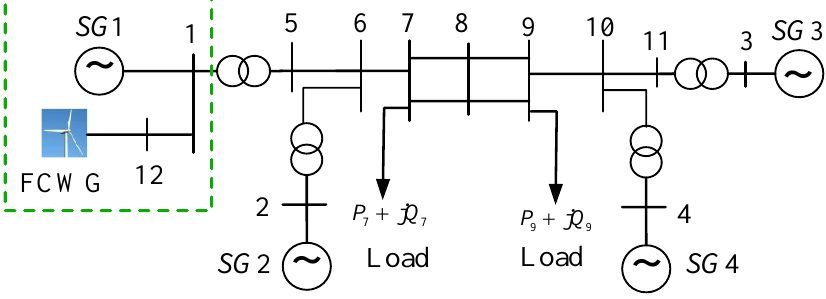
Figure 6. Configuration of two-area power system integrated with an FCWG wind farm.